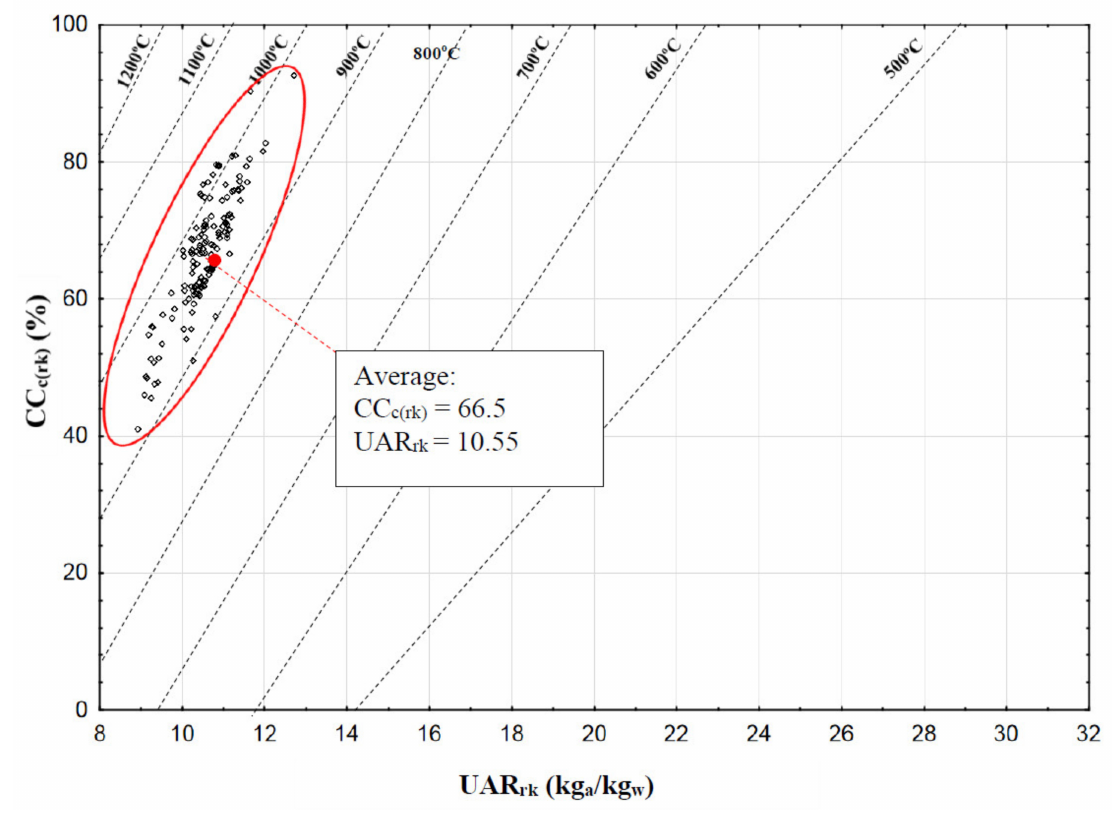
Figure 4. Chart of variability of process parameters in